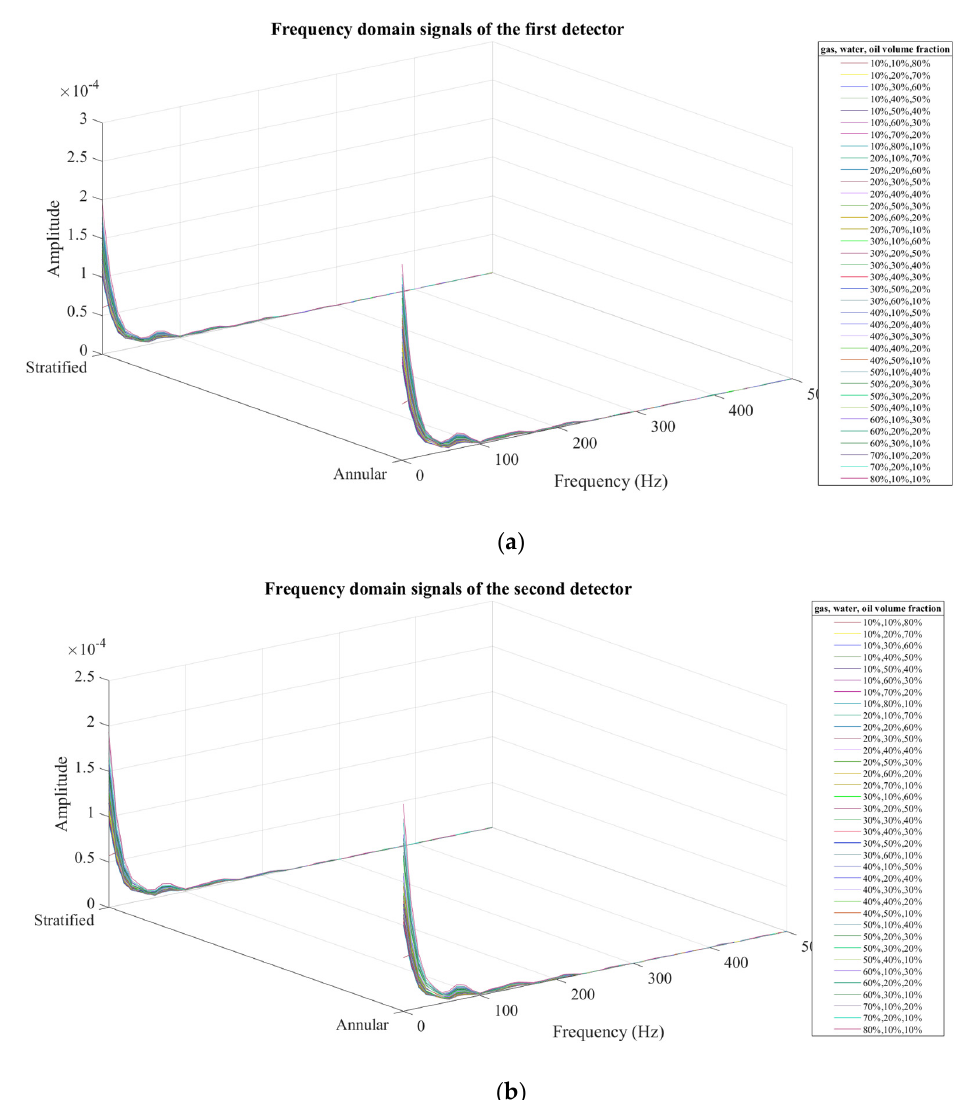
Figure 5. Transmitted signals to the frequency domain of ( a ) the first detector and ( b ) the second detector.